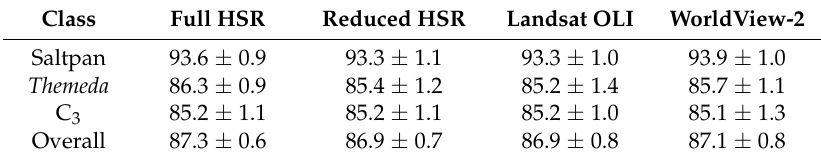
Table 2. Average random forest (RF) training accuracy for all three-class results. Accuracies are given as a percentage obtained by averaging the results of all 30 RF training models. Standard deviations are given as a percentage value above or below the mean. HSR denotes ‘High Spectral Resolution’.